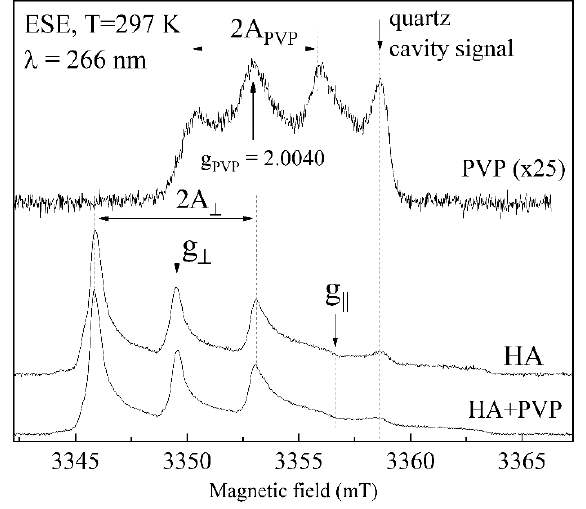
Figure 7. Pulsed EPR spectra for PVP (upper curve), HA (middle curve) and sample 1 (lower curve) under UV radiation ( λ = 266 nm) at room temperature in the W-band. Signal from PVP is shown at much higher enhancement (25 × ) compared to HA and sample 1. Signal arising from the quartz tube is